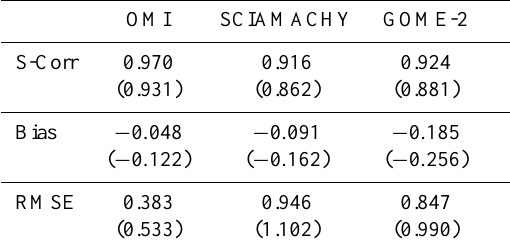
Table 5. Comparisons of global tropospheric NO 2 columns be- tween the control run and the satellite retrievals in brackets, and be- tween the reanalysis run and the satellite retrievals: OMI for 2005– 2012, SCIAMACHY for 2005–2011, and GOME-2 for 2007–2012. S-Corr is the global spatial correlation coefficient. The bias repre- sents the control run or reanalysis minus the retrievals. The aver- aging kernel of each retrieval is applied to the control run and the reanalysis. The units for the RMSE and bias are 10 15 moleccm − 2